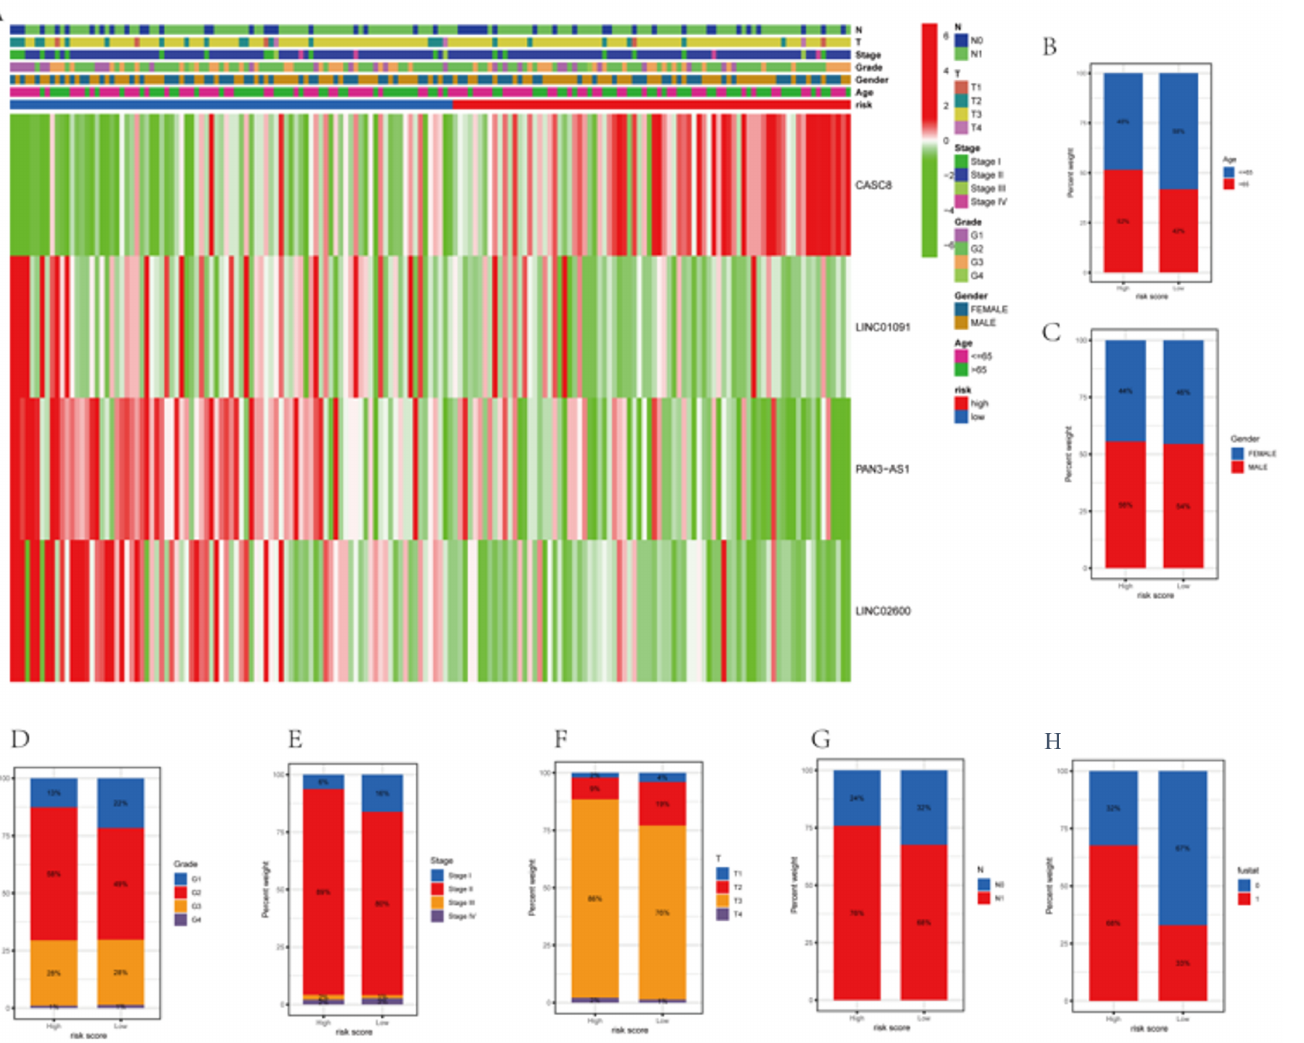
Figure 6. Differences in the clinicopathological characteristics in risk subgroups. ( A ) The heatmap shows the clinicopathological characteristics of patients in high-risk and low-risk groups. ( B – H ) The differences between the high-risk and low-risk groups for various pathological traits are presented as